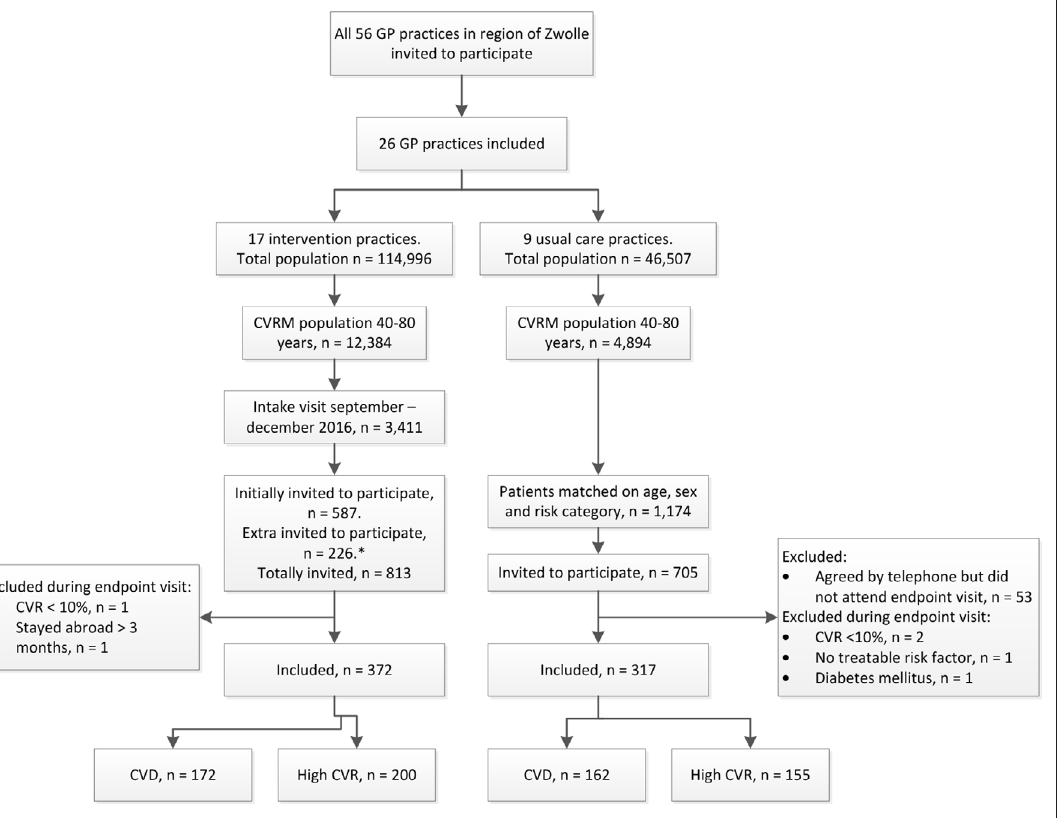
Figure 1 ZWOT- CASE study flow diagram. CVD = cardiovascular disease. CVR = cardiovascular risk. CVRM = cardiovascular risk management. * As the response rate in the intervention group was lower than the expected 70%, the required sample size was not reached after 587 intervention patients were invited. Therefore, 226 extra patients were invited to the intervention group (total invited n = 813) and they were matched retrospectively to the usual care